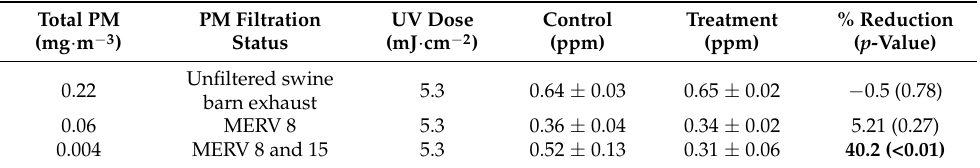
Table 12. Performance of UV-A photocatalysis in mitigating H 2 S concentrations under different PM signifies statistical significance.